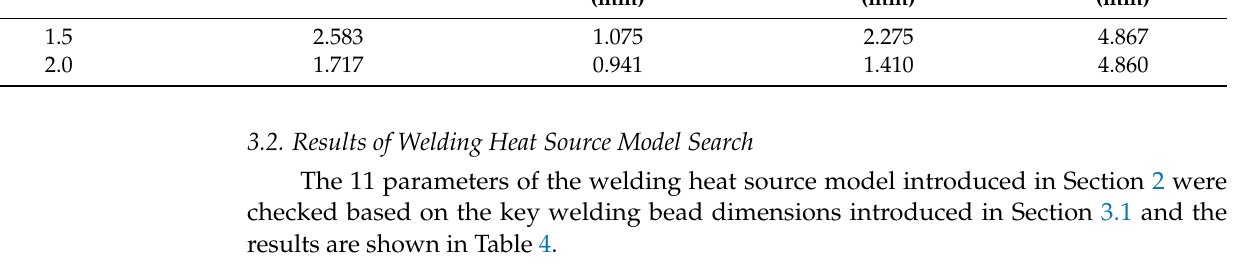
Table 4. Key parameters of welding heat source per welding